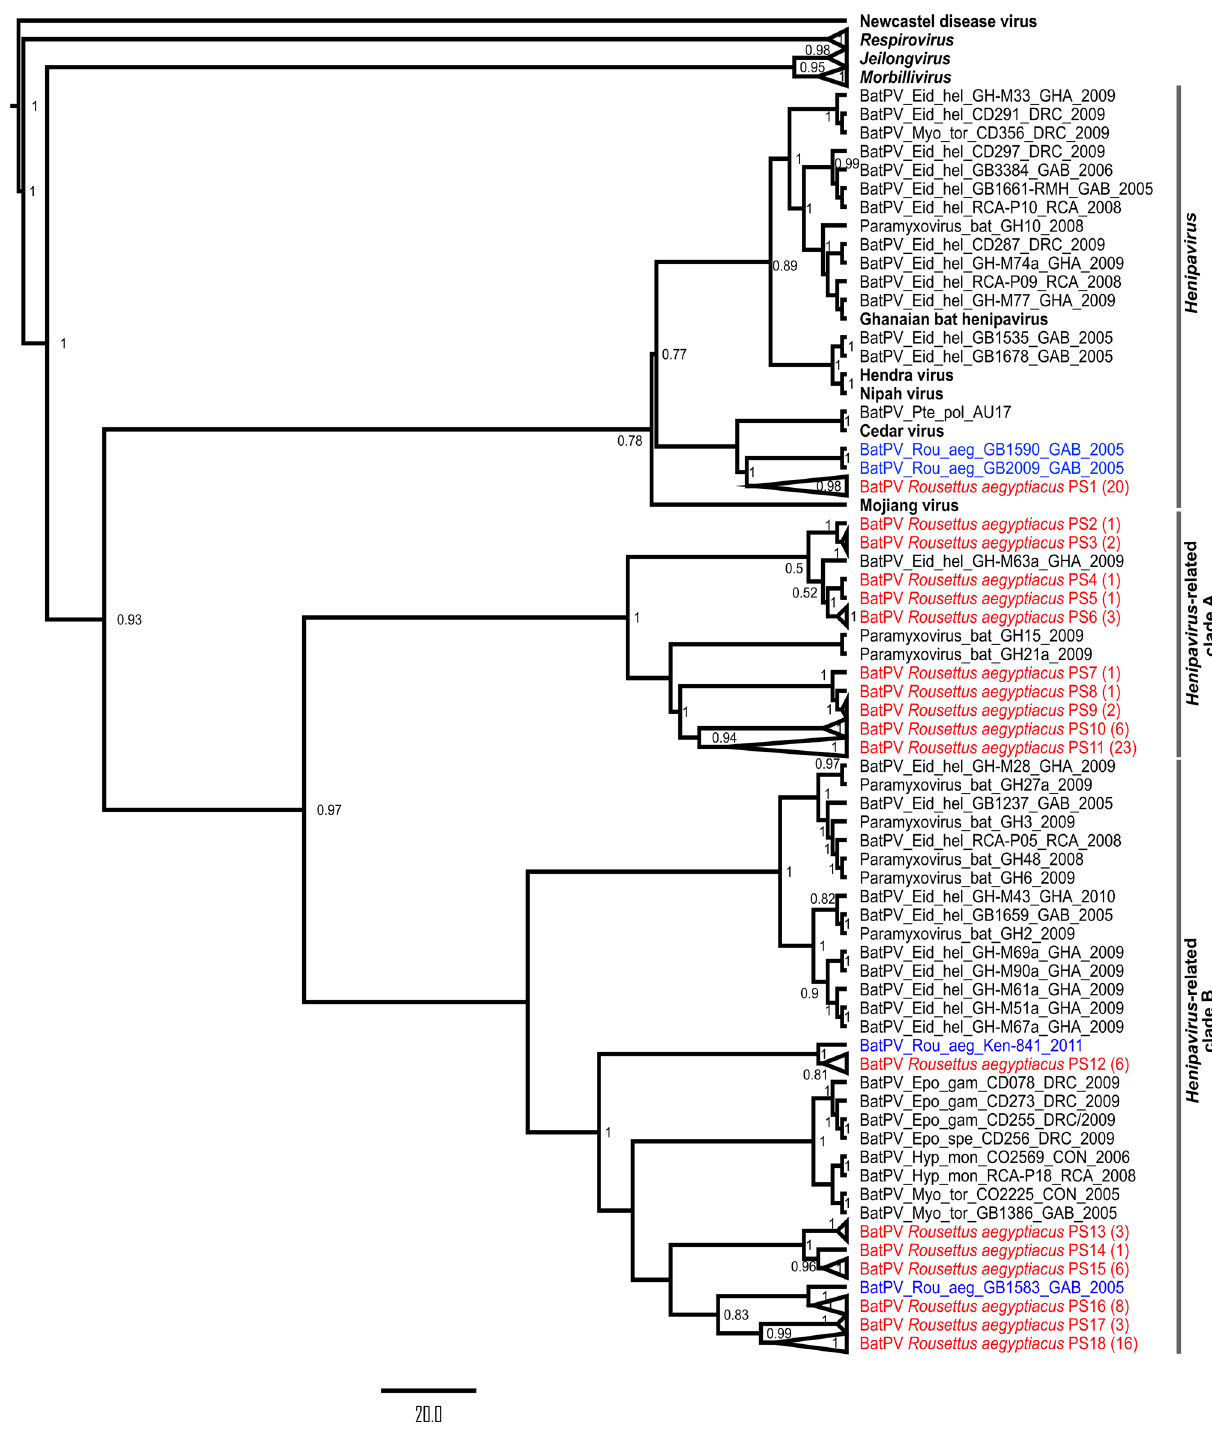
Figure 3. Bayesian phylogenetic analyses of partial paramyxovirus polymerase (L) gene sequences detected in Egyptian rousette bats. The proportional phylogeny was based on an alignment of sequences with 439 nucleotide lengths. Bayesian phylogenetic analysis was performed using the TIM3 + I + G substitution model with a resulting effective sample size (ESS) value of 594.3. Sequence names in red represent sequences detected in this study, blue—sequences detected in the same bat species from other countries, and black—representative sequences from the literature. Numbers in brackets at the end of red sequence names indicate the number of detections per sequence. Posterior probabilities of more than 0.5 are indicated at internal nodes, and large clades were collapsed. Newcastle disease virus was selected as an outgroup, and other Orthoparamyxovirinae genera are indicated in bold italics. GenBank accession numbers for all sequences used in the phylogenetic analyses are provided in Supplementary Tables S1 and